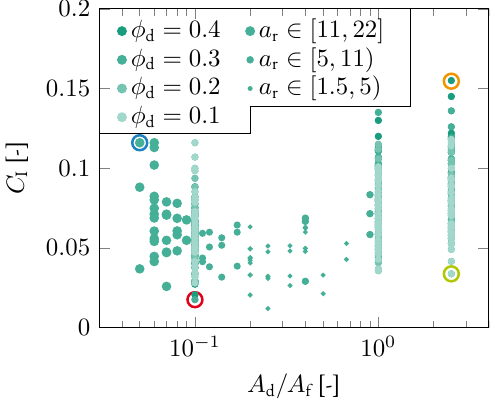
Figure 9. C I over area ratio of disks to fibers A d / A f